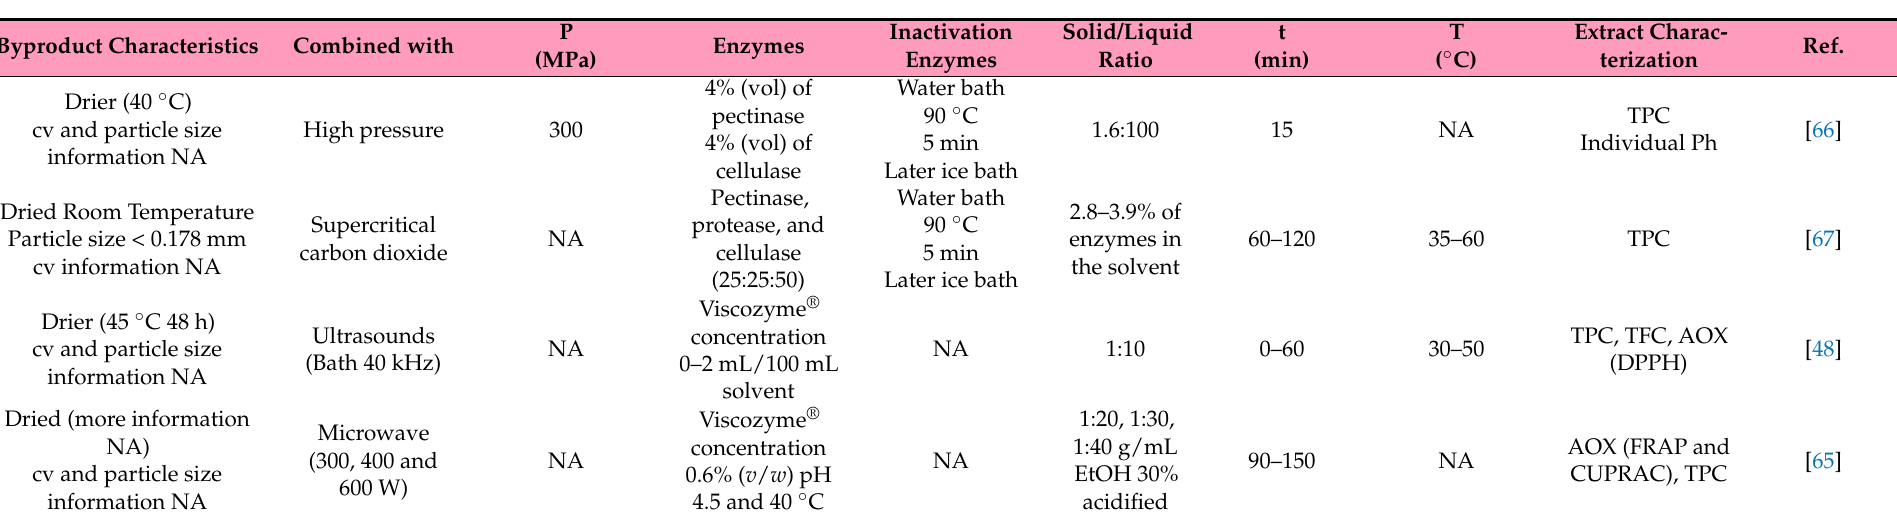
Table 3. Enzymatic assisted conditions (enzyme, pressure, time, temperature) for the extraction of bioactive compounds from pomegranate